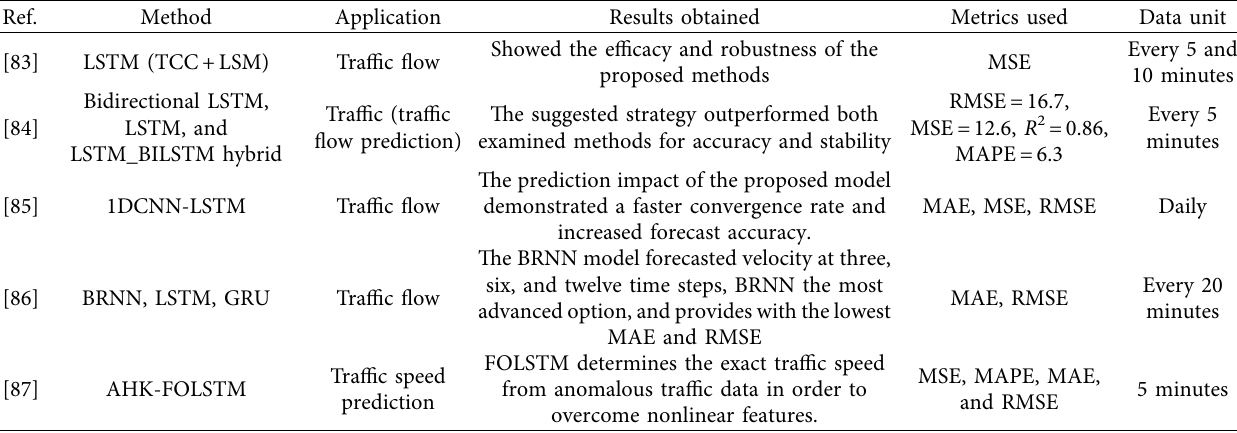
Table 6: A summary of published articles that used deep sequential models in traffic flow predictions.